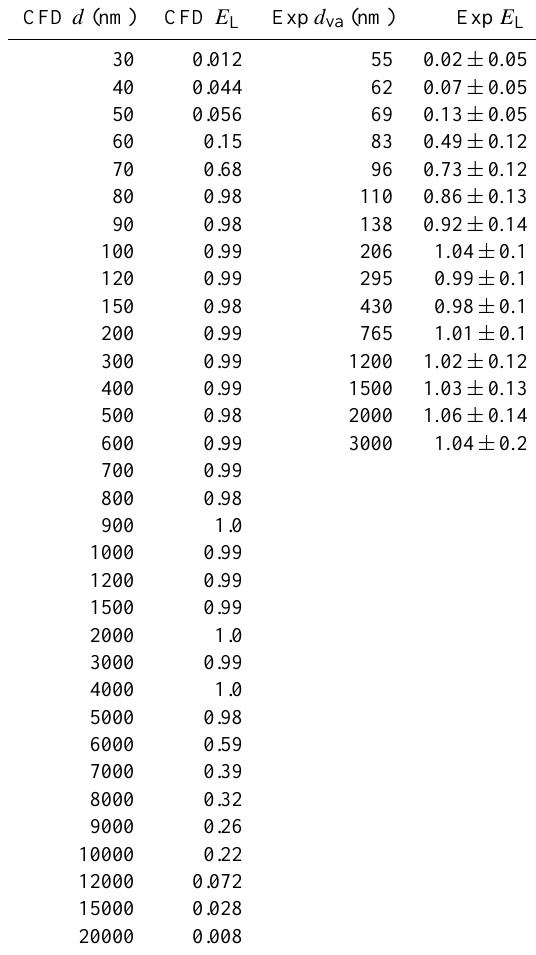
Table 2. Calculated and experimental transmission efficiency, E L , for the high-pressure